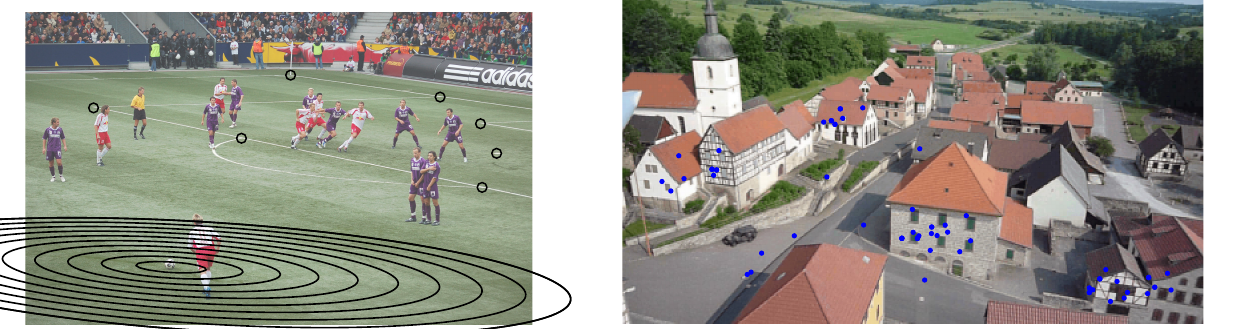
Figure 6. Direct free kick. The superimposed nested ellipses are concentric circles on the field, with multiples of 1 yard as radii. The encircled seven image points have been used to estimate the field-to-image homography. Photo taken by Markus Dallarosa, licensed by W CC BY-SA-3.0.